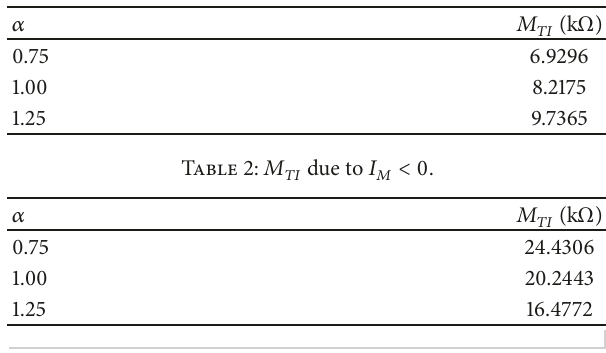
Table 1: 𝑀 𝑇𝐼 due to 𝐼 𝑀 > 0 .